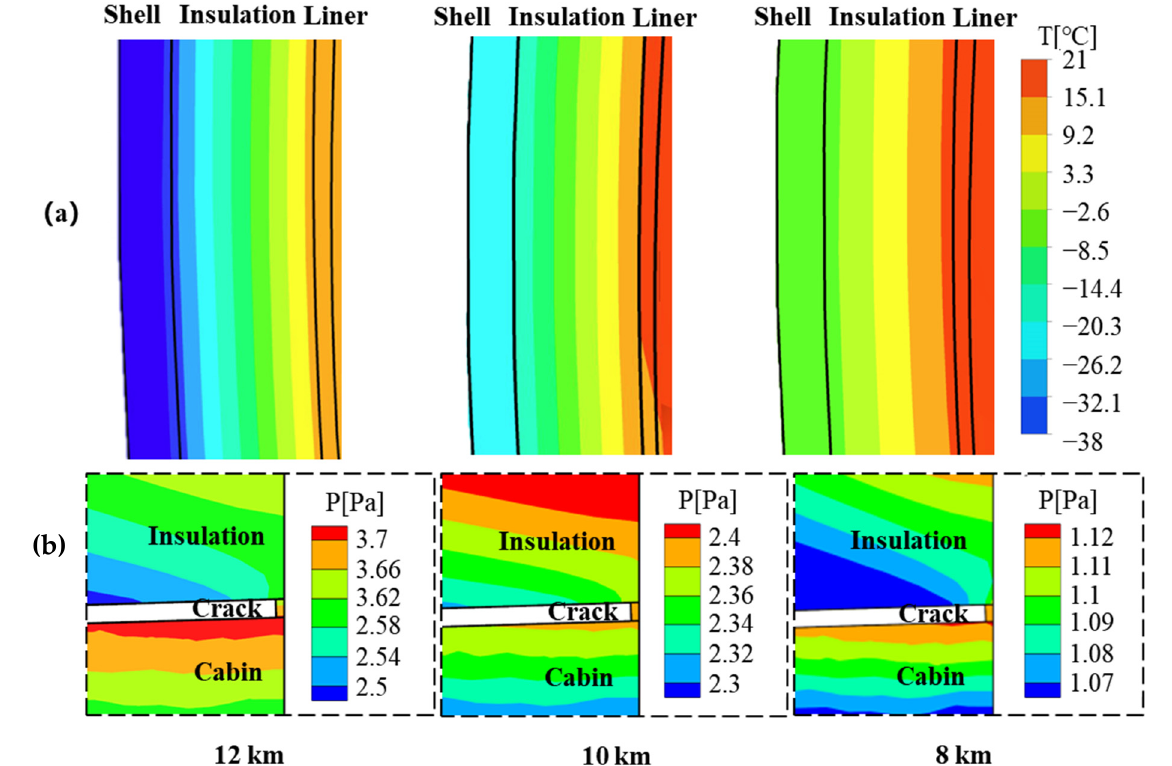
Figure 8. Temperature and pressure distribution under different cruising altitudes of a flight: ( a ) temperature distribution for a section of the envelope wall, ( b ) pressure distribution surrounding Crack 1 on the